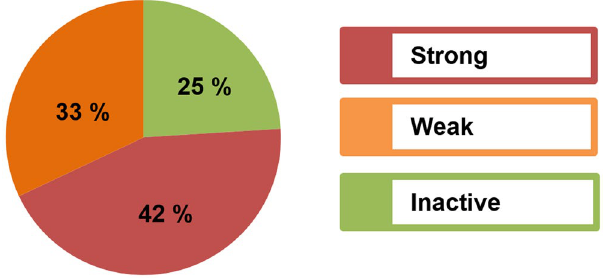
Figure 6. Screening for CYP2D6 inhibitory properties of the preselected compounds at a concentration of 100 µ M. A strong or intermediate inhibition was observed for 18 out of 24 compounds. Only 6 compounds exhibited more than 50% of total luminescence, indicating inactivity at 100 µ M.